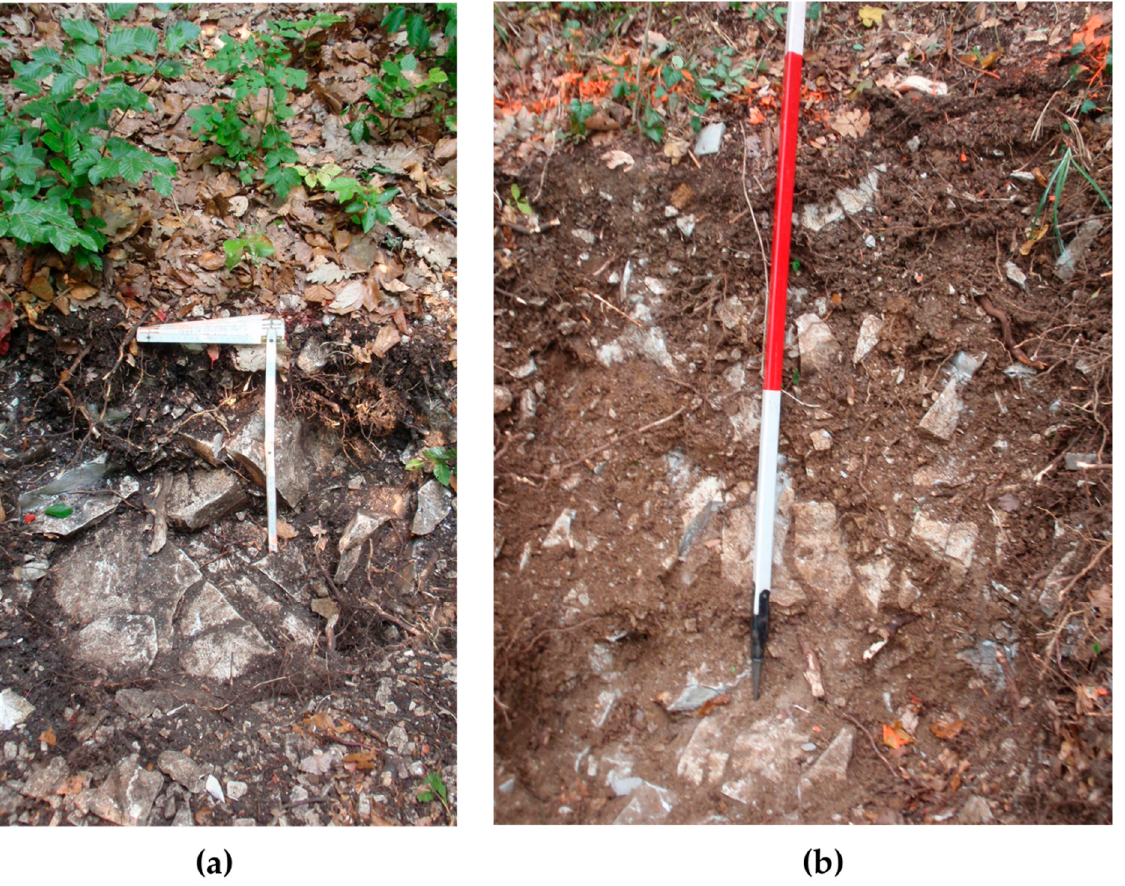
Figure 4. Picture of two soil profiles dug separately in dry and less-dry plots in the study area: ( a ) Soil profile at a dry plot in Seinbruch, Klettgau; soil depth: 34 cm; available soil water storage capacity: 46 mm; ( b ) soil profile at a less-dry plot in Schönberg, Schwäbische Alb; soil depth: 92 cm; available soil water storage capacity: 103.2 mm.